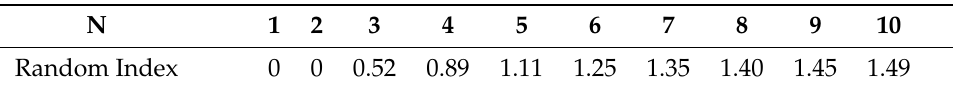
Table A8. Table for random index (RI)